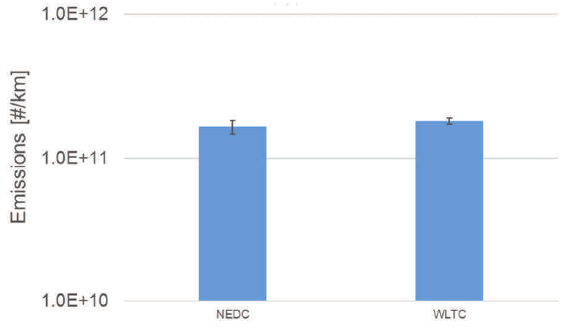
Fig. 8. PN emissions (solid particles only) from vehicle 3